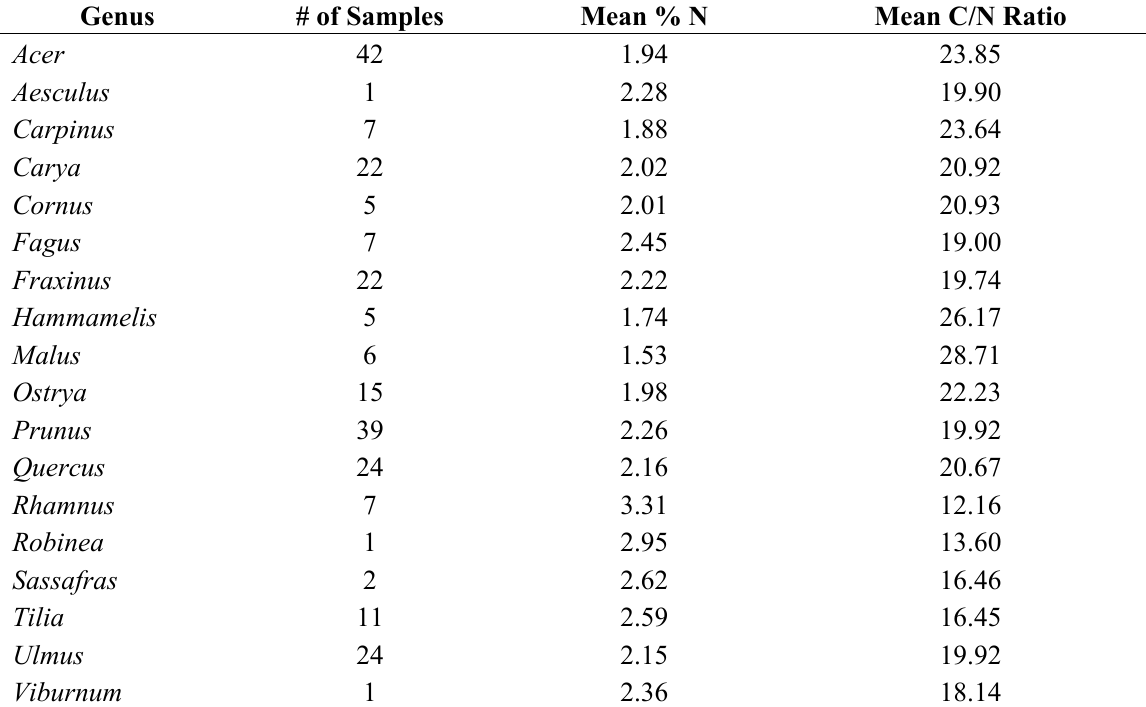
Table 5. Foliar Chemistry Sample